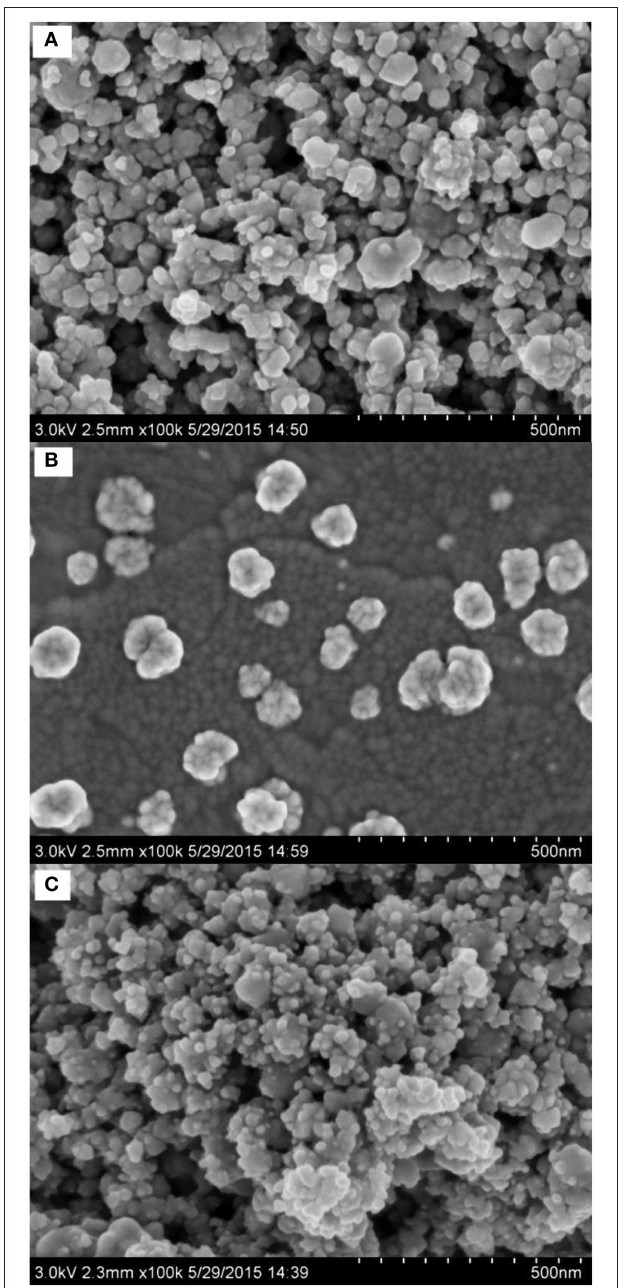
FIGURE 2 | SEM images of Nano-TiC/GCE (A), AuNPs/GCE (B), and AuNPs/Nano-TiC/GCE (C).